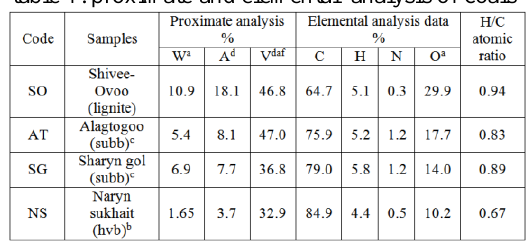
a -Oxygen is determined by difference